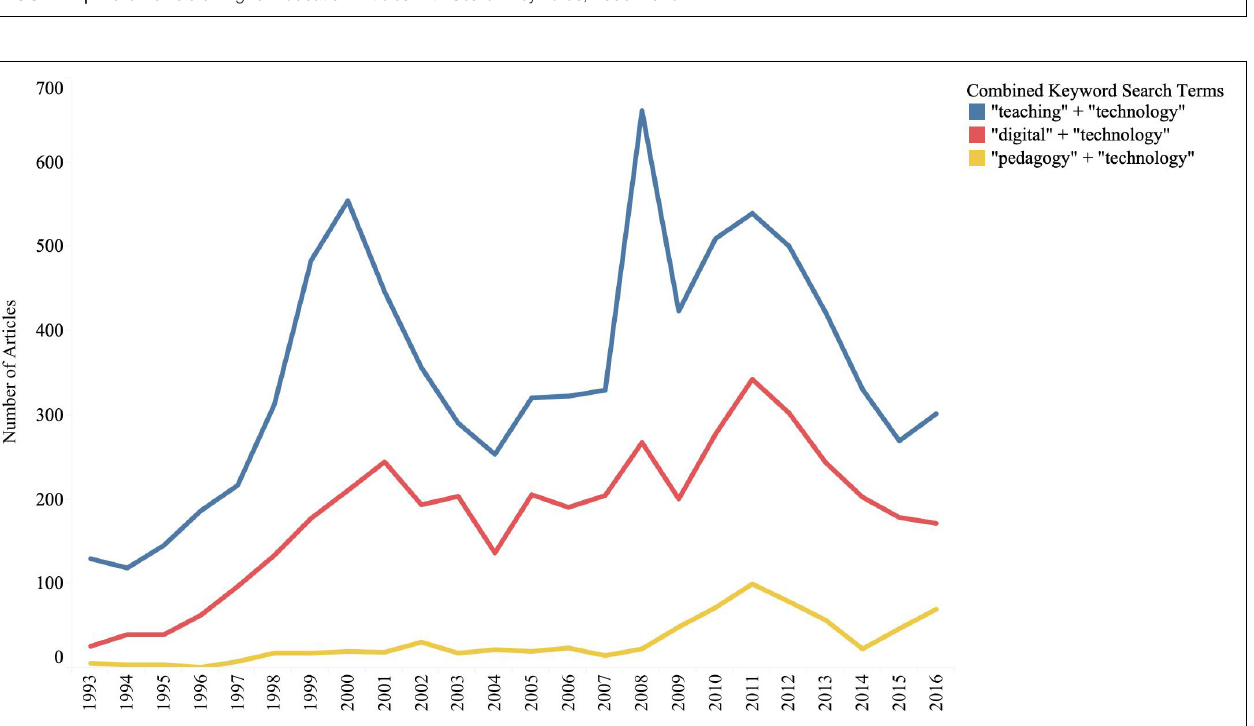
FIGURE 2 | Articles with combined search keywords in The Chronicle of Higher Education , 1993–2016. “Teaching” + “technology” yielded a total of 8,346 articles; “digital” + “technology” yielded a total of 4,362 articles; “pedagogy” + “technology” yielded a total of 748 articles.